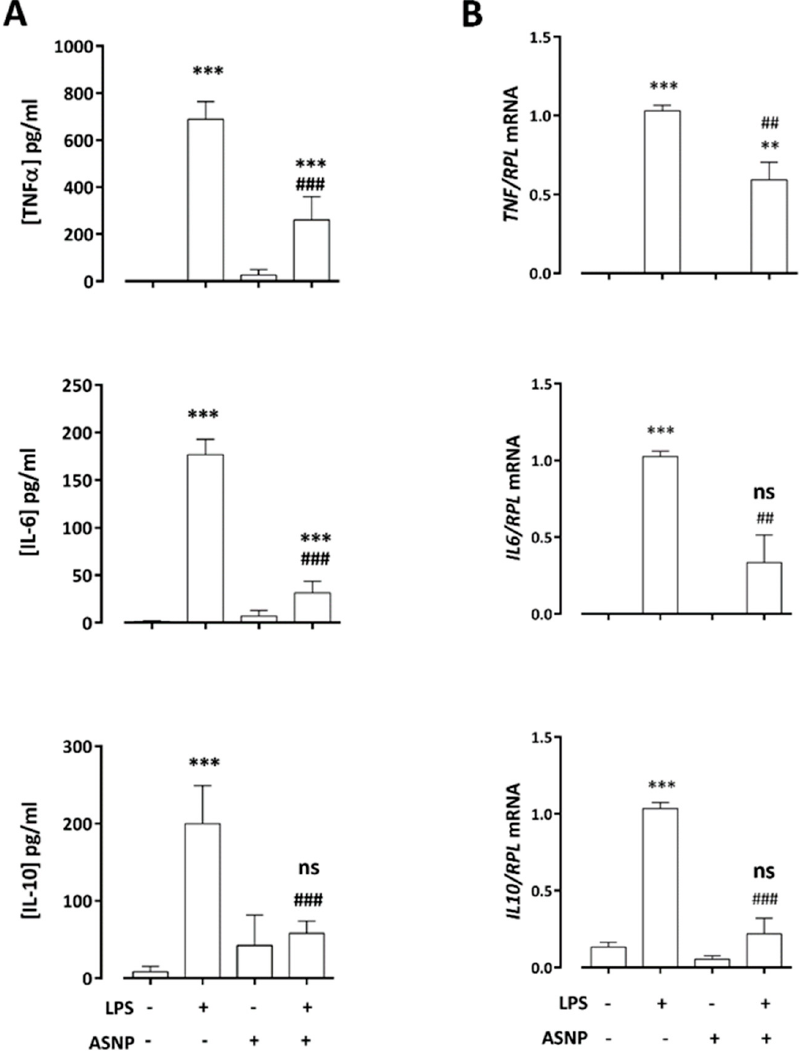
Figure 2. Effects of ASNP exposure on LPS-dependent cytokine induction. Macrophages were exposed to ASNP (10 μ g/cm 2 ), as described in Materials and Methods, and challenged with LPS 1 ng/mL in the last 24 h of incubation. ( A ) Secreted cytokines after 24 h of LPS treatment. Data are means of six determinations ± SD obtained from two independent experiments. ( B ) Gene expression after 2 h of LPS treatment. Data are means of four determinations ± SD in two independent experiments. ** p < 0.01, *** p < 0.001 vs. control; ## p < 0.01, ### p < 0.001 vs. LPS 1 ng/mL; ns = not significant vs. control. ( A ), one-way ANOVA followed by a Tukey’s multiple comparisons test; ( B ), two-tail t -test for unpaired